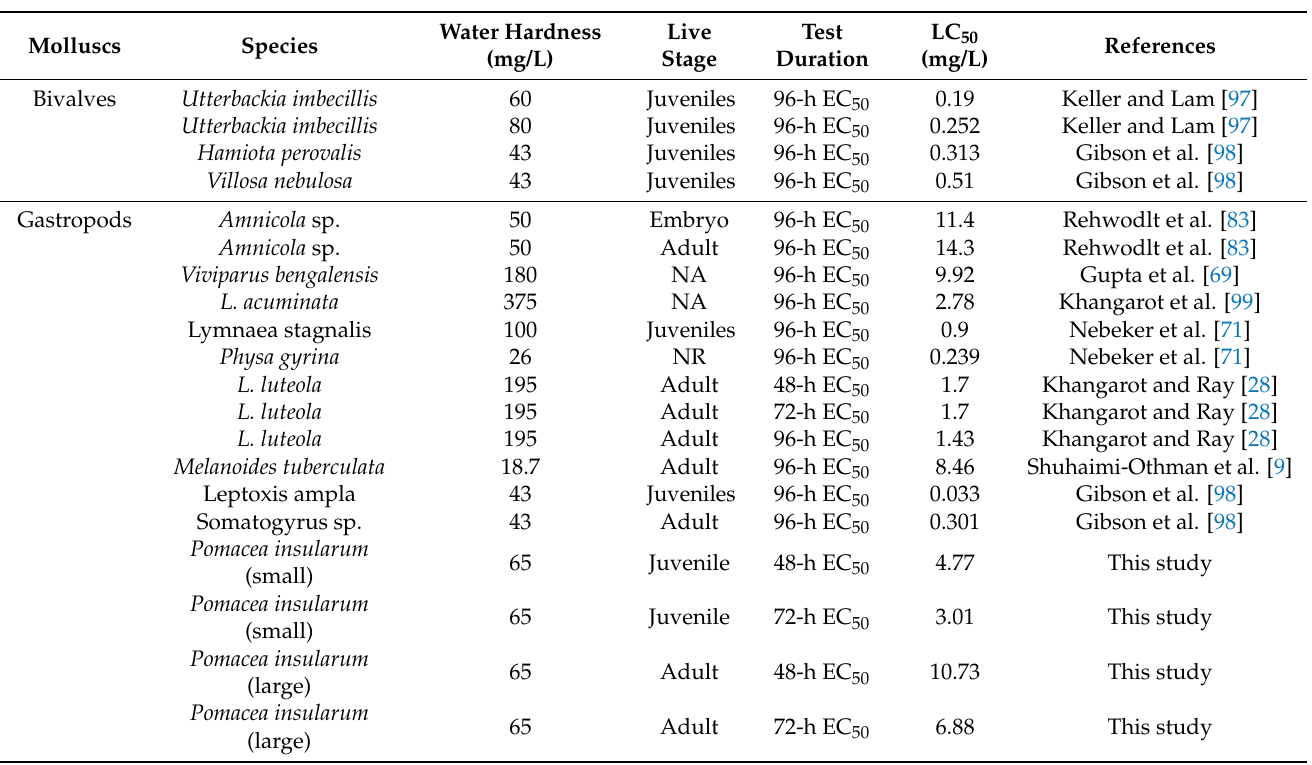
Table 4. Comparison of LC 50 values (mg/L) of Ni in Pomacea insularum with other mollusks reported in the literature.